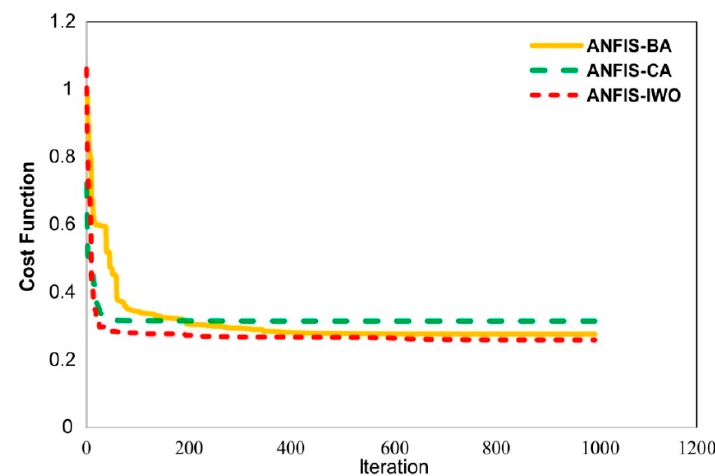
Figure 11. Speed of convergence of applied models.